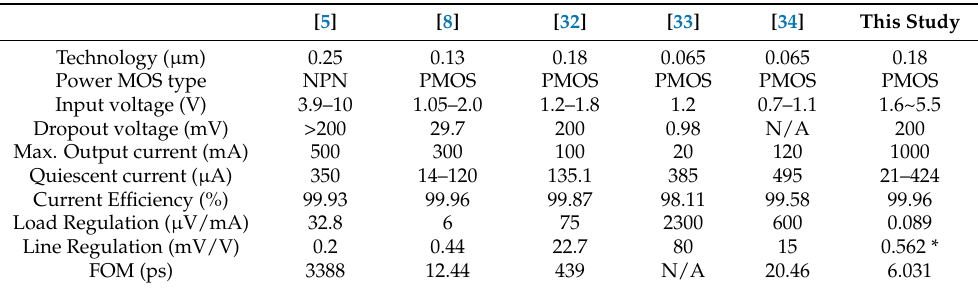
Table 1. Performance comparison with reported